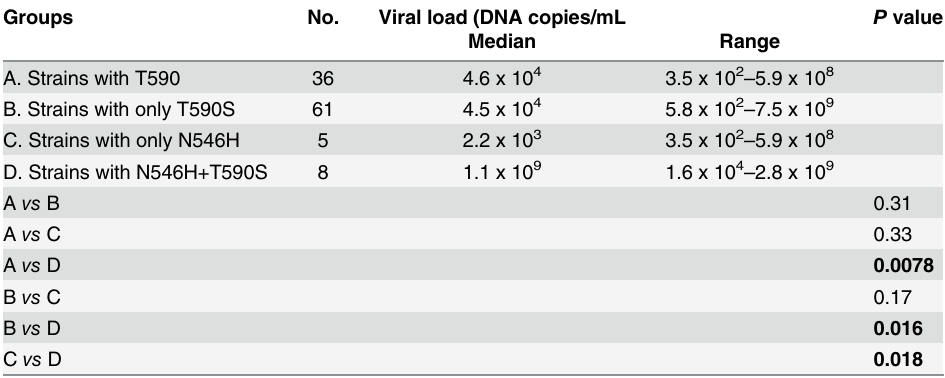
Table 3. Presence of mutations in human bocavirus strains and relation of mutations with viral load.